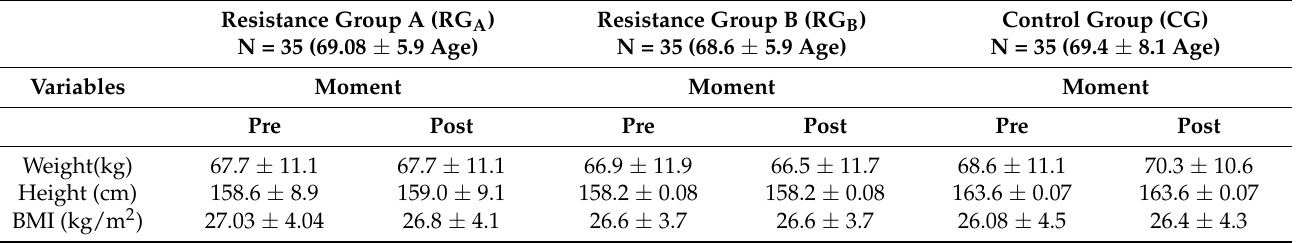
Table 1. Mean and standard deviation of anthropometric assessment before and after the intervention for training and Control